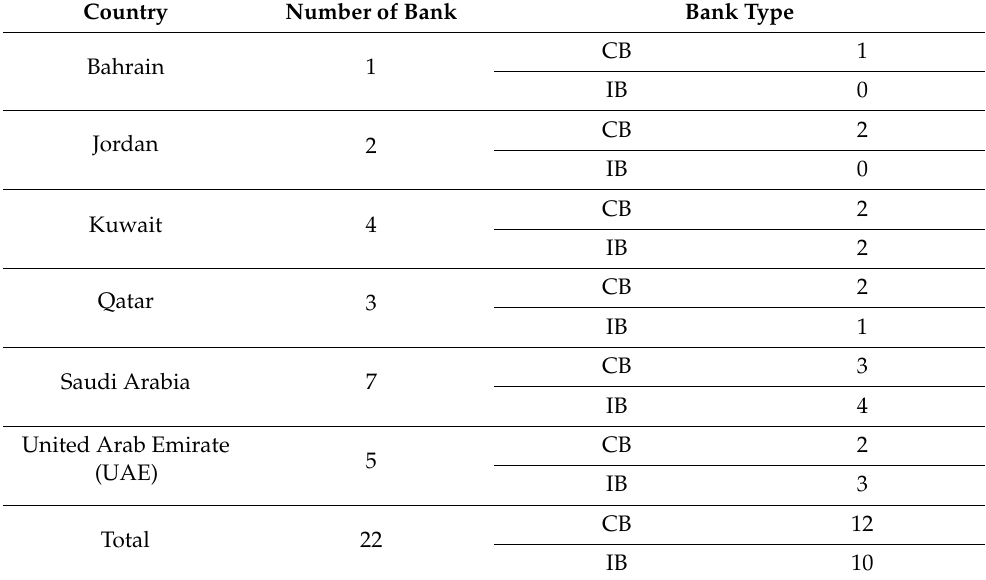
Table 1. Description of the sample. Country Number of